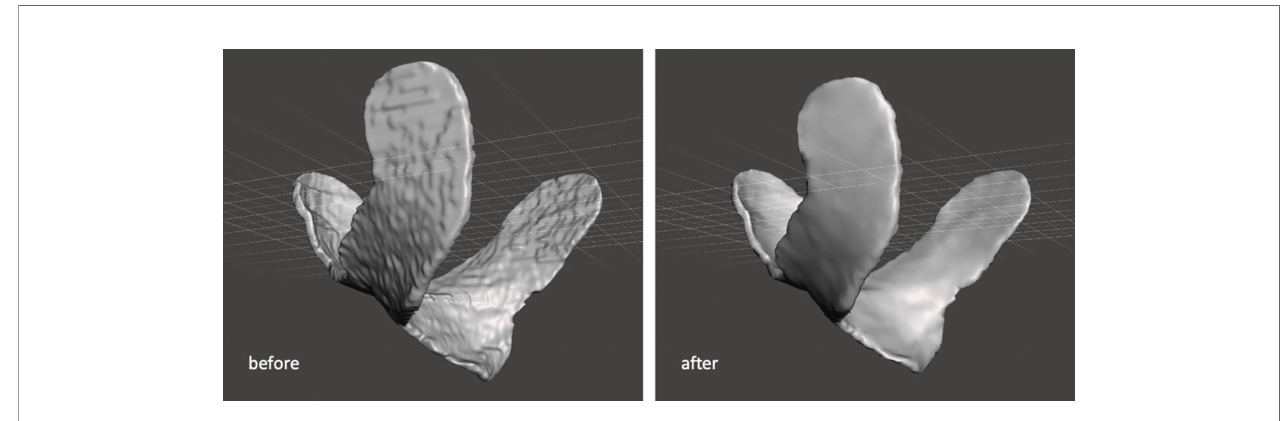
FIGURE 3 | Smoothing the contour of 3D-conformal bolus.